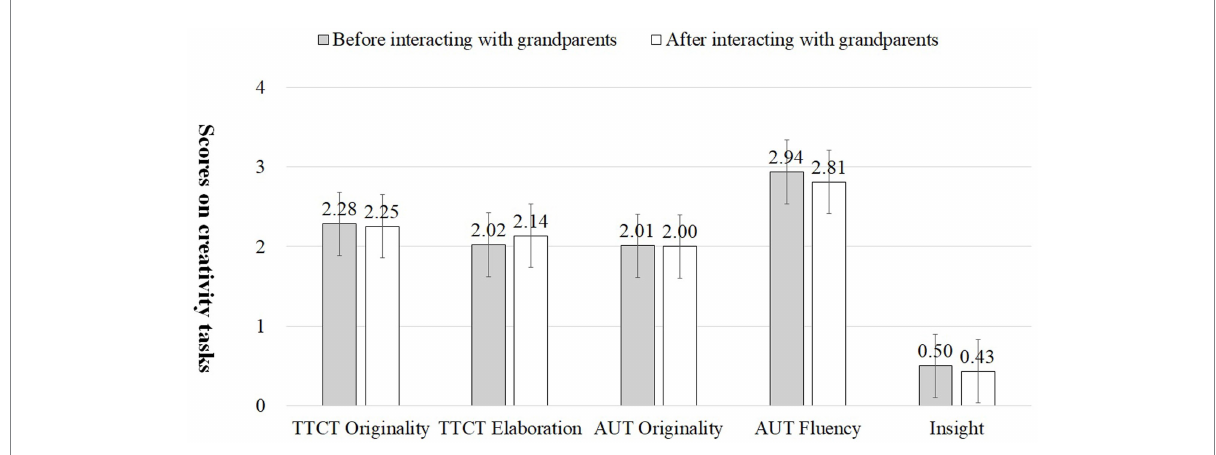
FIGURE 4 Differences in children’s scores on creativity tasks before and after interaction with